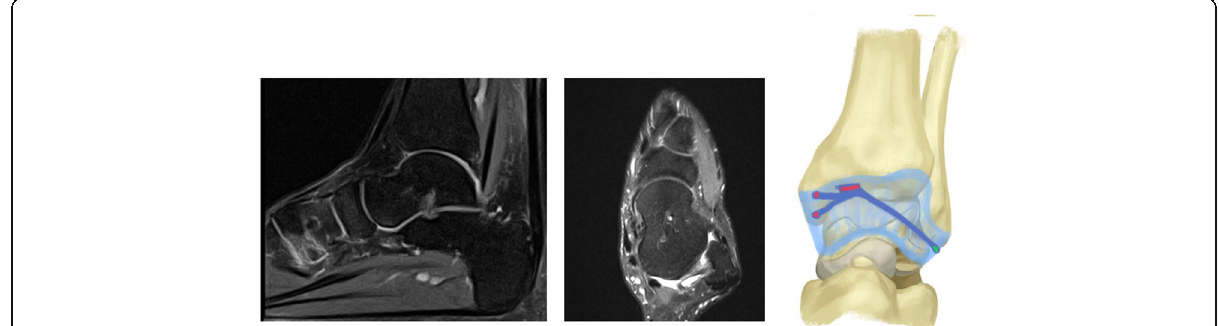
Fig. 4 Sagittal and axial MRI views, and the shape of the fibrous band in patient